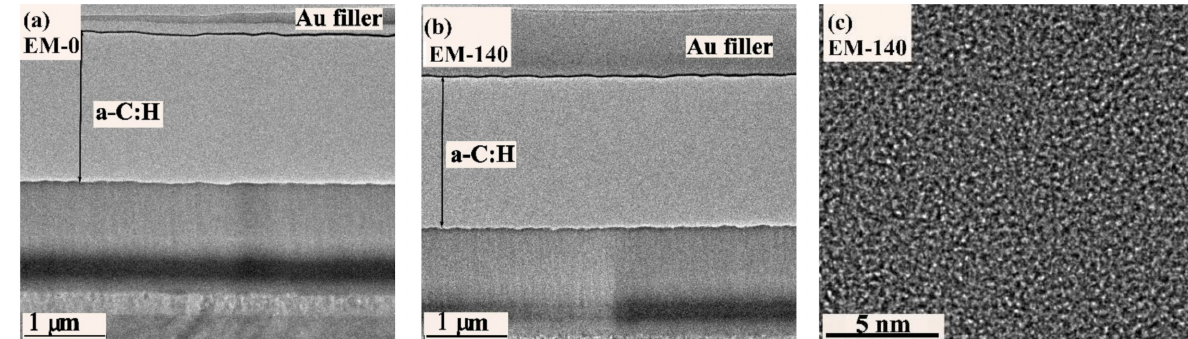
Figure 2. TEM images of the cross-sections ( a , b ) and plan-view HRTEM image ( c ).